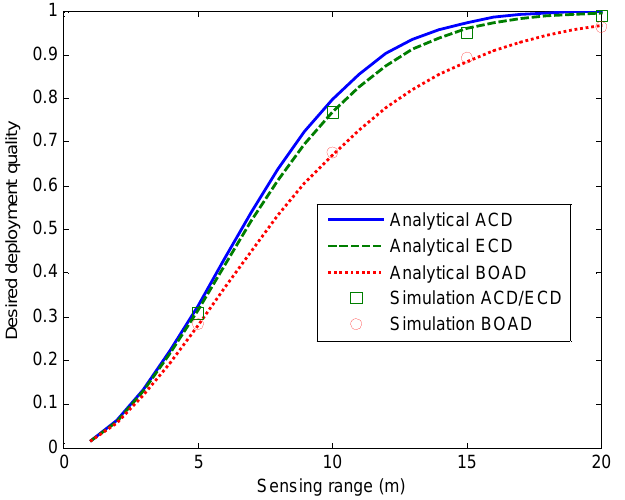
Figure 12. Effects of sensing range on the DDQ for n =